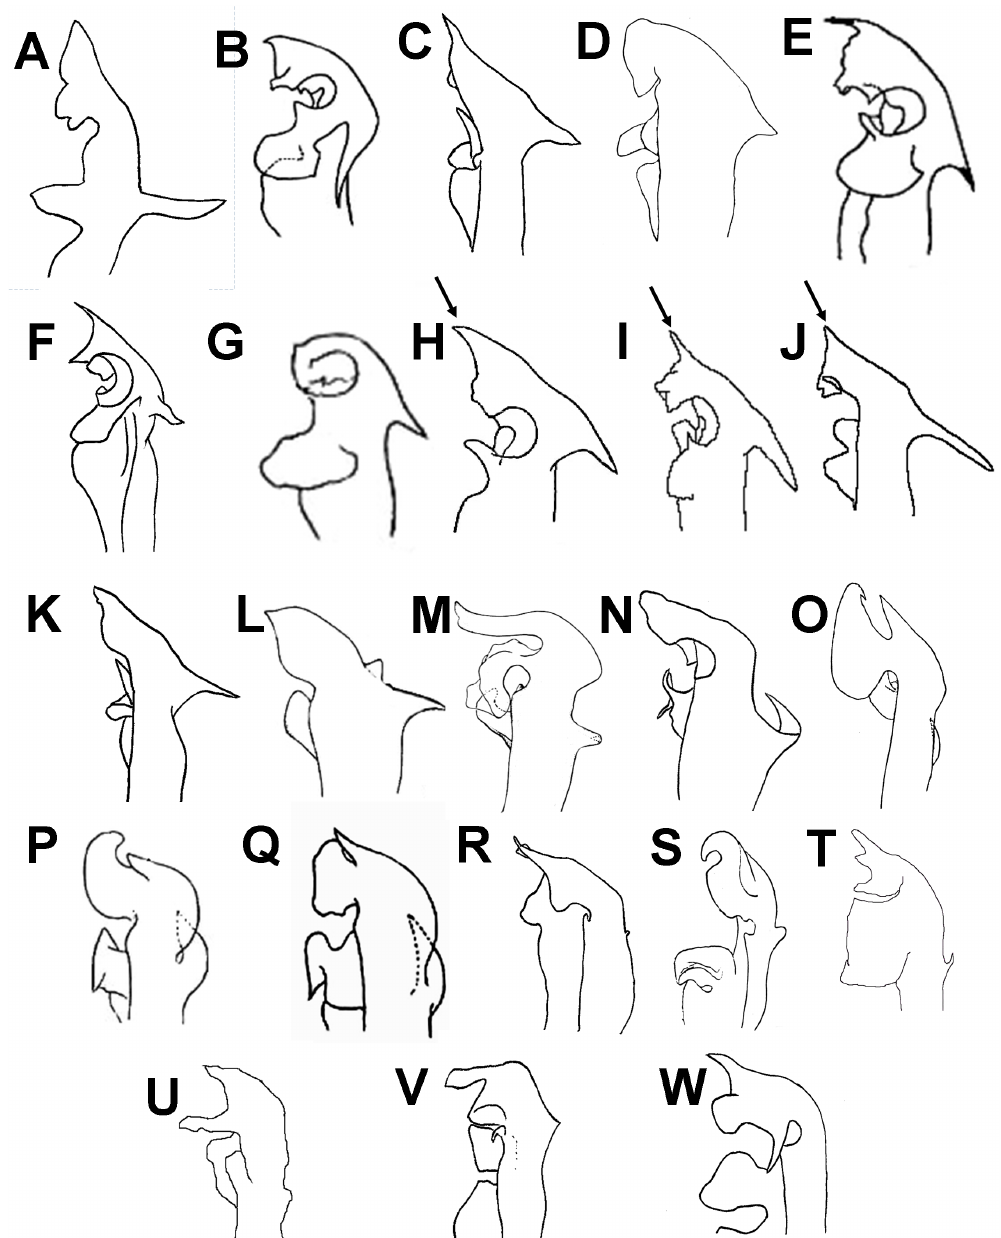
Fig. 9. Prionopetalum spp., outlines of distal part of gonopod coxa. The species appear in the sequence in which they key out in the identification key. A . P. megalacanthum (after a specimen in